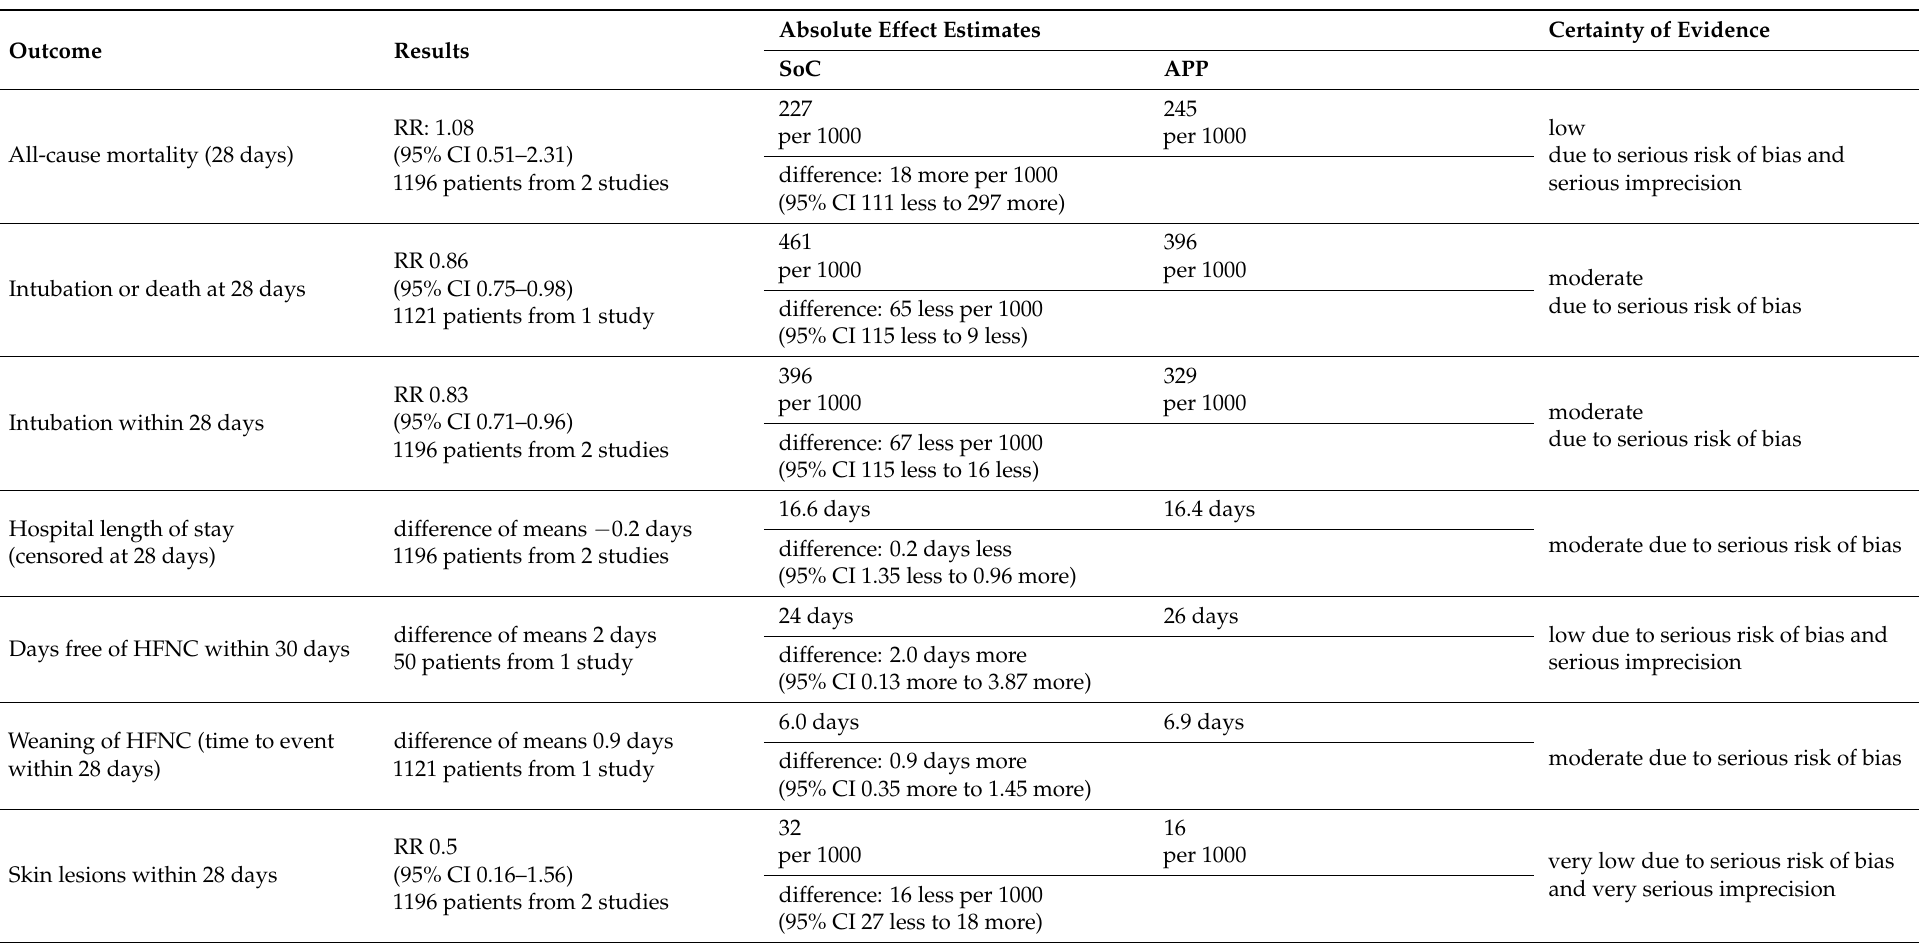
Table 4. Summary of findings—effects of awake prone positioning on predefined outcomes. RR: relative risk; CI: confidence interval; SoC: standard of care; APP: awake prone positioning; HFNC: high-flow nasal